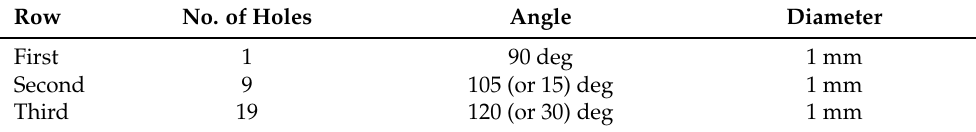
Table 3. Air bearing—bottom